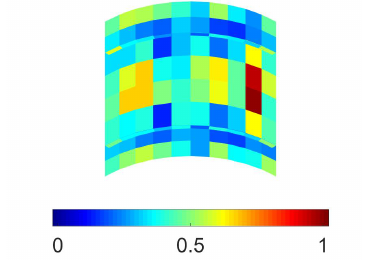
Figure 10. Stiffened fuselage section problem, Case (2), macroscale analysis: contour plot of the objective function ψ M